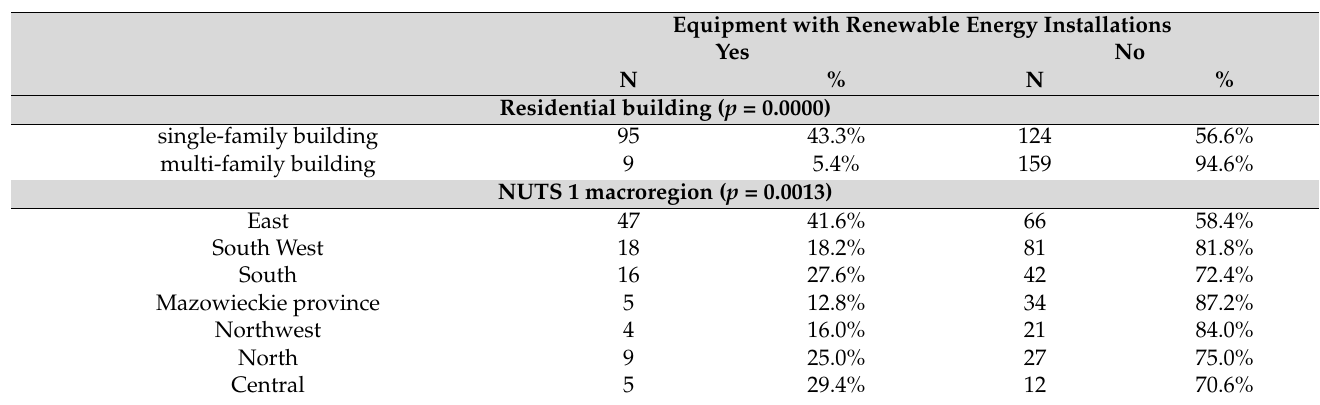
Table 4. Share of energy from renewable energy sources in total household energy consumption. N = 104. Share of Energy Obtained from RES 100.0 Source: own study. *N = 104, number of respondents with RES installations.